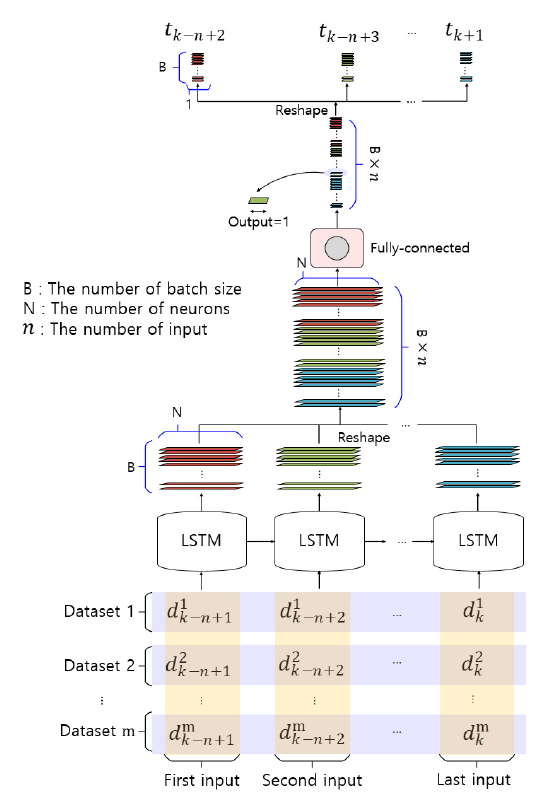
Figure 7. Actual LSTM network structure used in the experiments to predict SSTs.